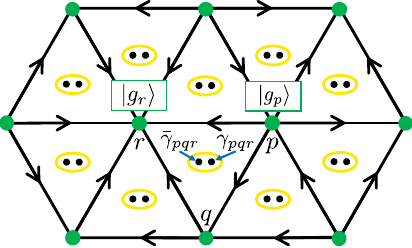
FIG. 12. The effect of